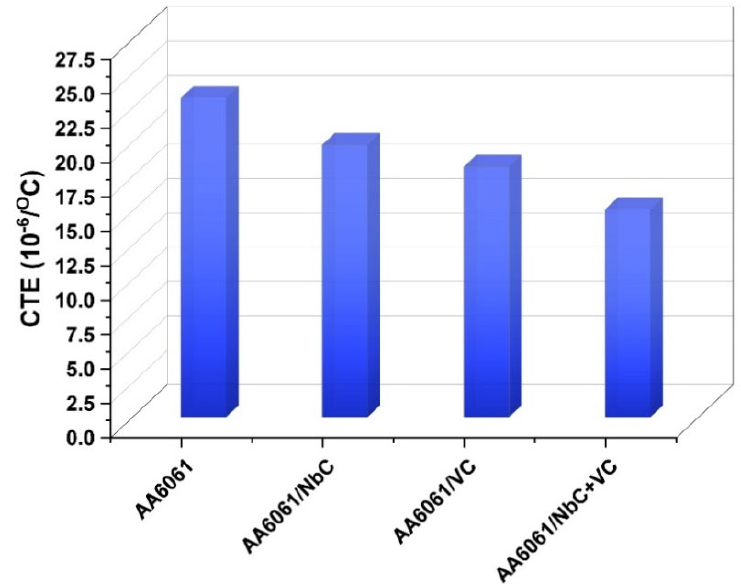
Figure 6. The CTE value of the investigated samples.